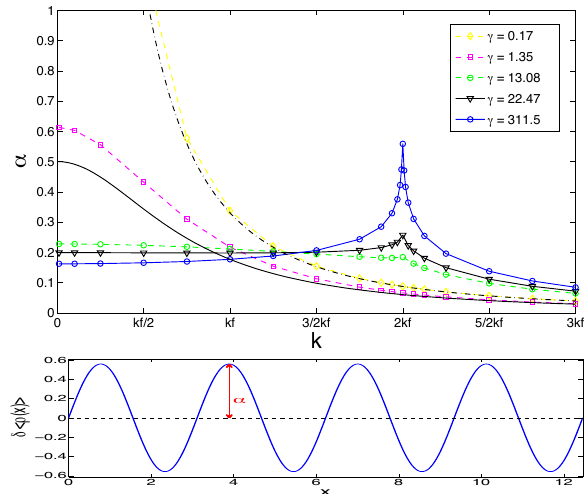
δ 〈 ρ ( x ) 〉 for different values of γ = g /ρ x . All calculations in both panels were done F